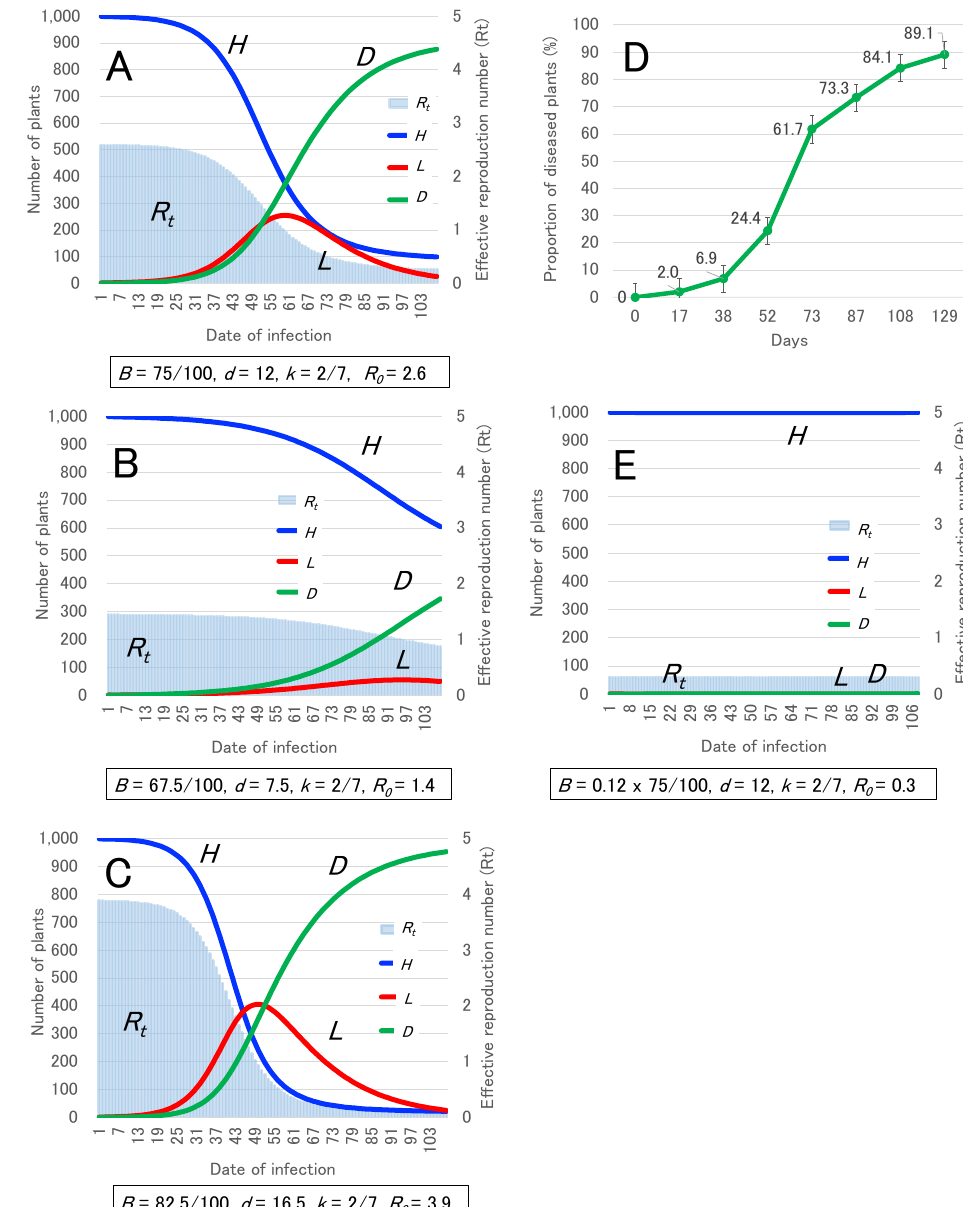
B = 82.5/100, d = 16.5, k= 2/7, R = 3.9 0 Figure 3. Development of HLD model of TBC and estimation of TBC transmission. ( A ) HLD model A and dynamics of the effective reproduction number ( R t ) of TBC. ( B ) model B and dynamics of R t . ( C ) model C and dynamics of R t . ( D ) dynamics of TBC incidence actually observed in commercial greenhouses in Okayama, Japan. Data was shown as the mean proportion of TBC incidence ( n = 3), and error bars show standard error of the mean (SEM). ( E ) estimation of H , L , D , and R t of TBC in the case of disinfection of scissors based on model